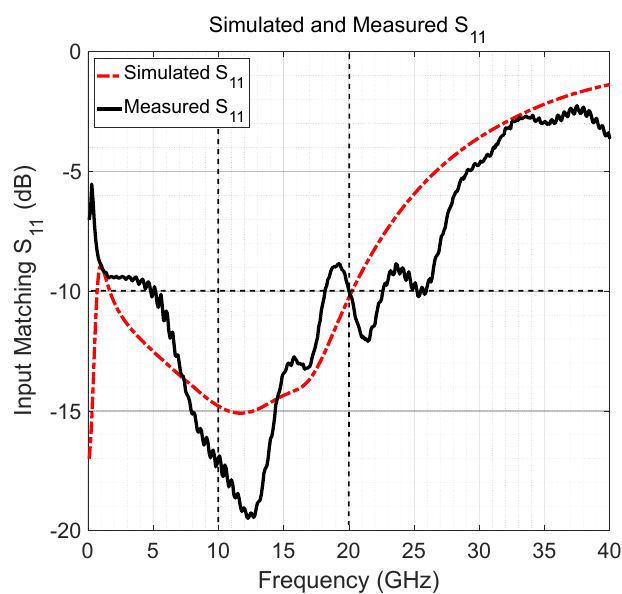
Figure 18. Simulated and measured input